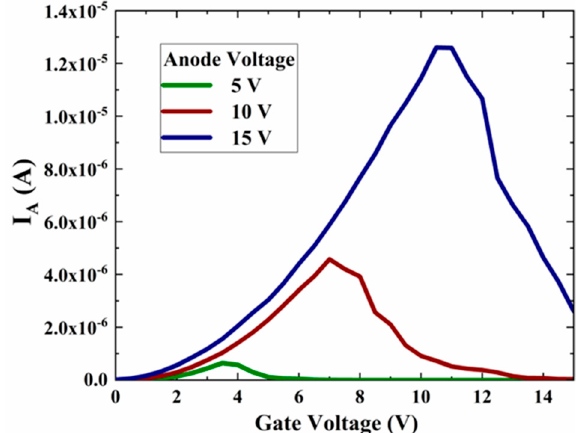
Figure 6 . Variation curves of the emitter current with the gate voltage for different anode voltages.